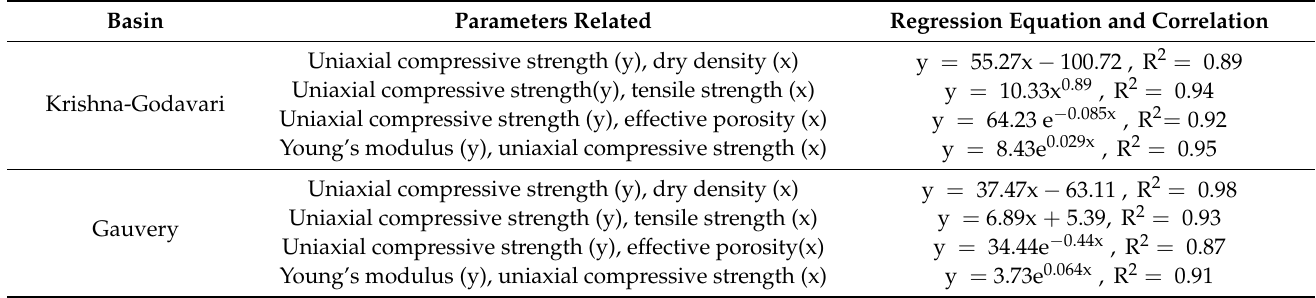
Table 16. Regression analysis of core samples in the Krishna-Godavari and Gauvery basins [119] (uniaxial compressive strength in Mpa, dry density in kg/m 3 , tensile strength in MPa, effective porosity in %, Young’s modulus in GPa). Regression Equation and Correlation